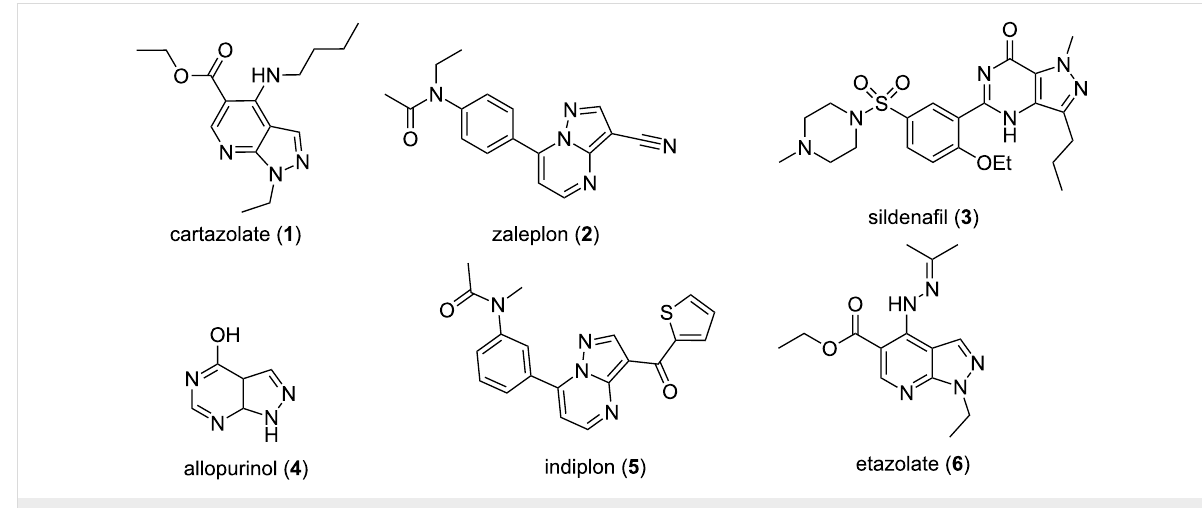
Figure 1: Selected examples of drugs with fused pyrazole rings.